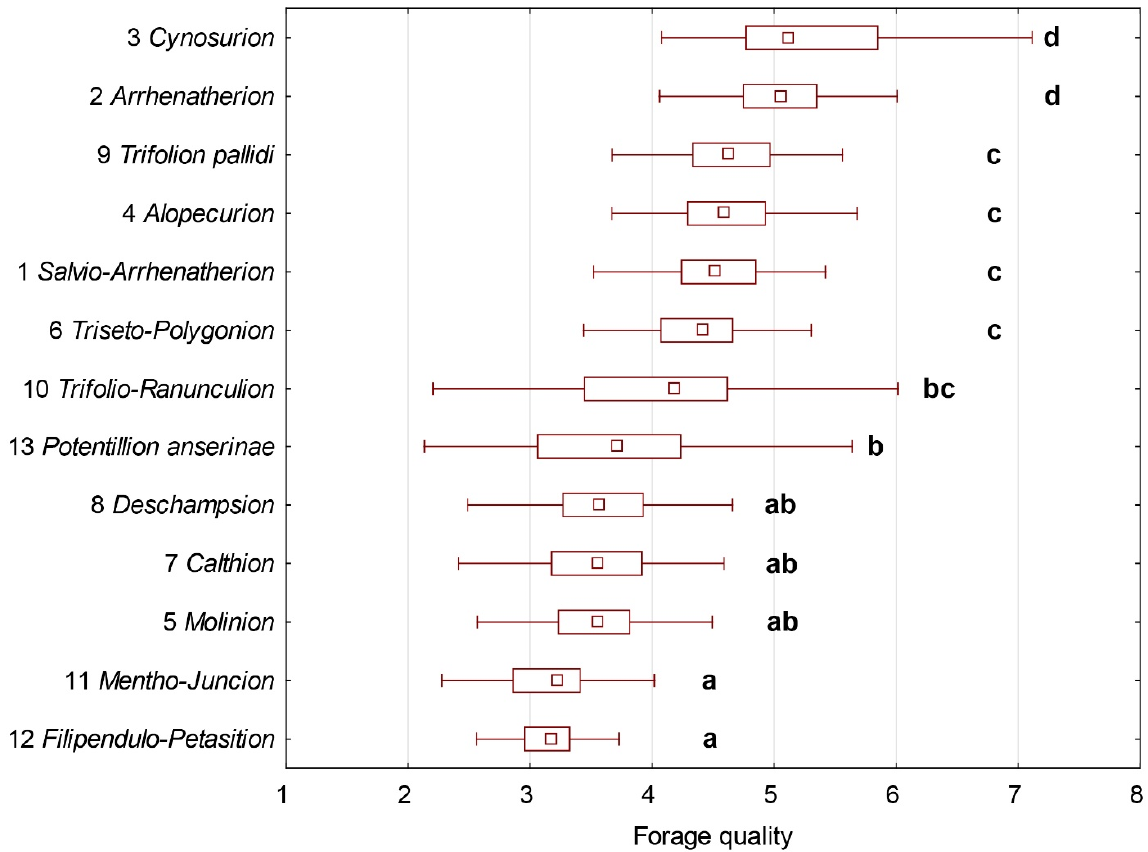
Figure 4. Box-whiskers diagram of forage quality of individual grassland types with multiple comparison of mean ranks (the same letter means that there is no significant difference). Legend is the same as in Figure 2.